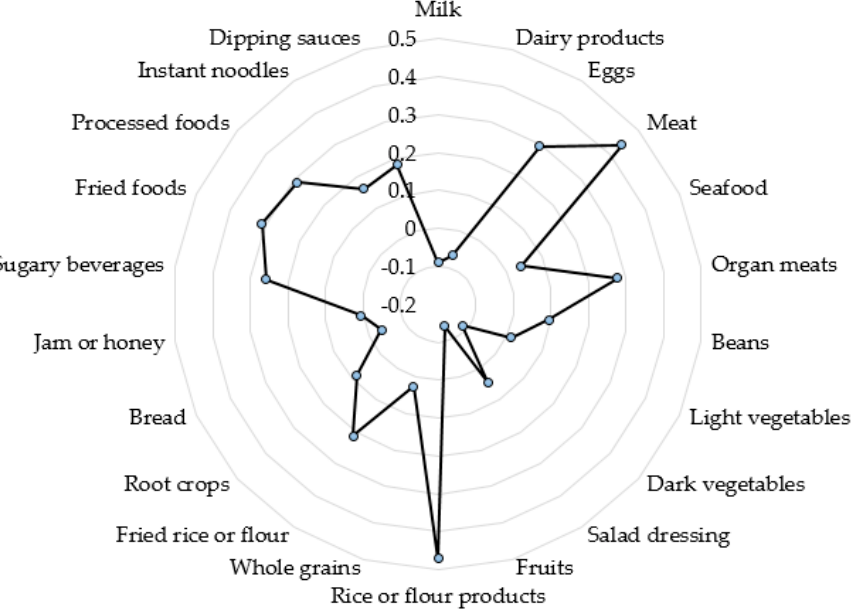
Figure 3. Spider web diagram of anemia–inflammation-related dietary pattern with factor loadings.